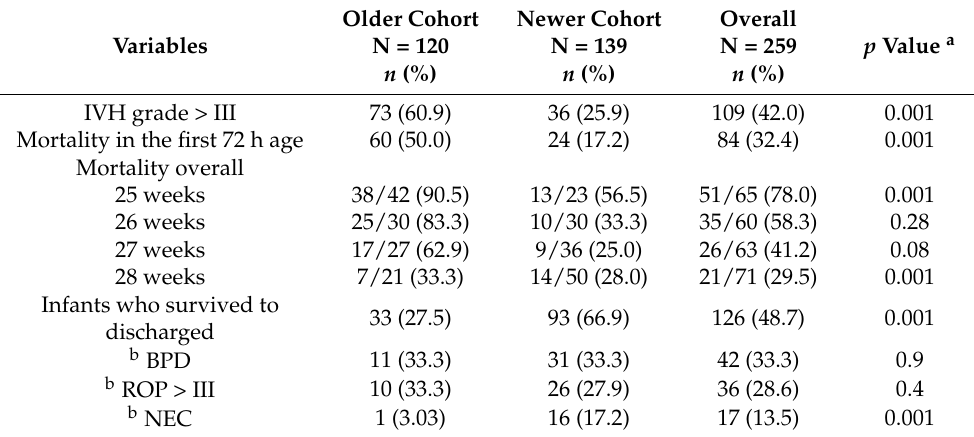
Table 2. Comparison of perinatal outcomes between two study periods.